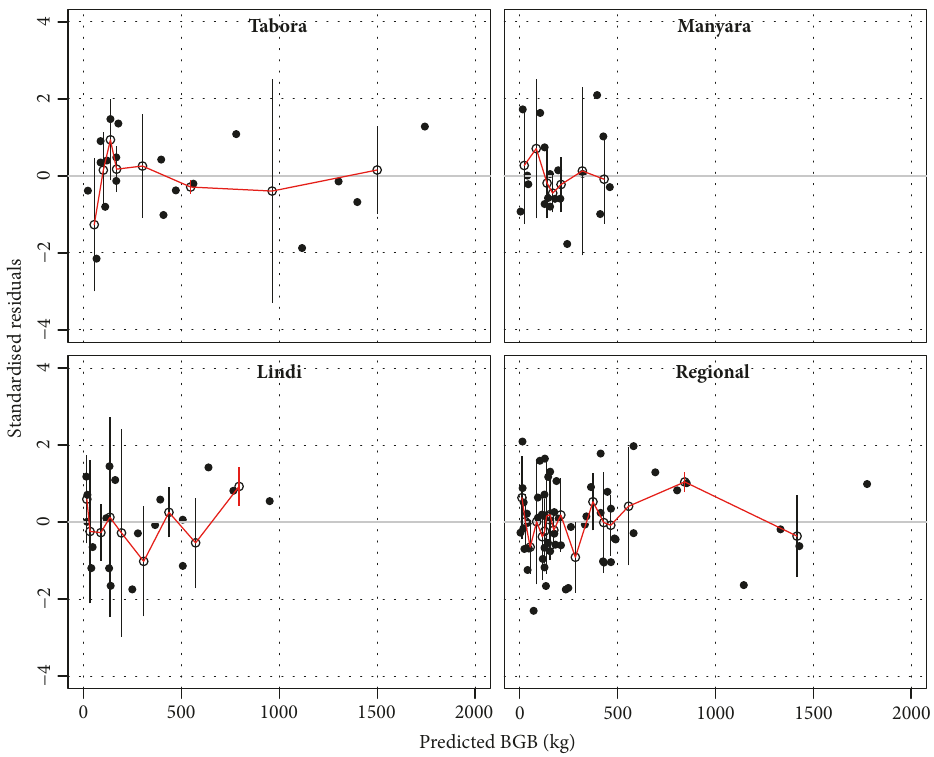
Figure 7: Residual plots of selected sites and regional belowground biomass models.